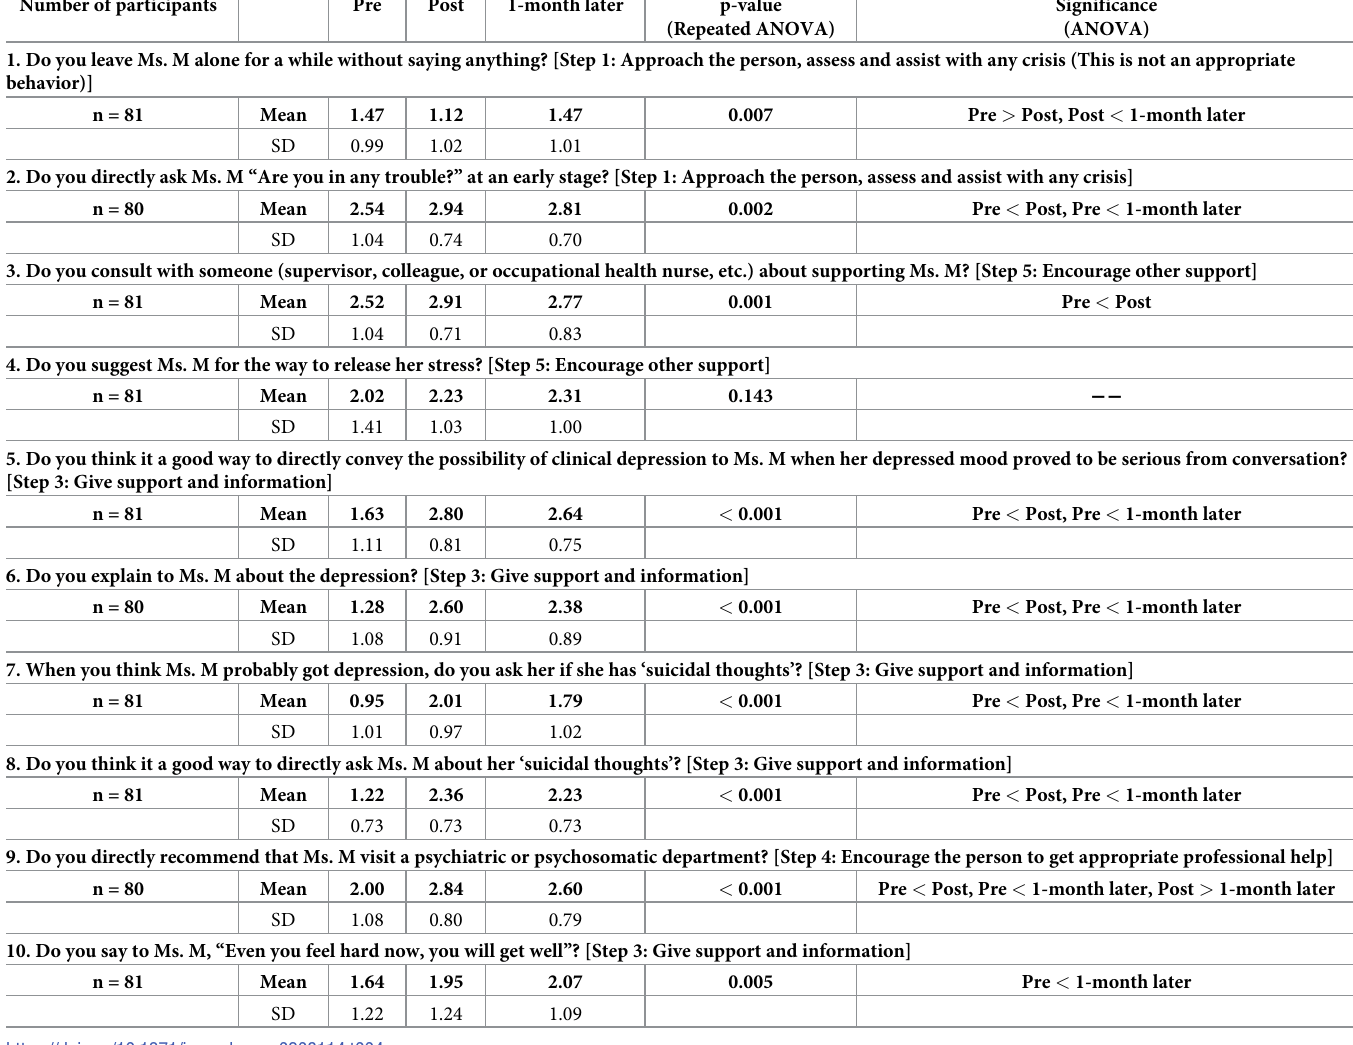
Table 4. Skills of supporting people with depression and suicidal risk (responses to a workplace case vignette). Number of participants Pre Post 1-month later p-value